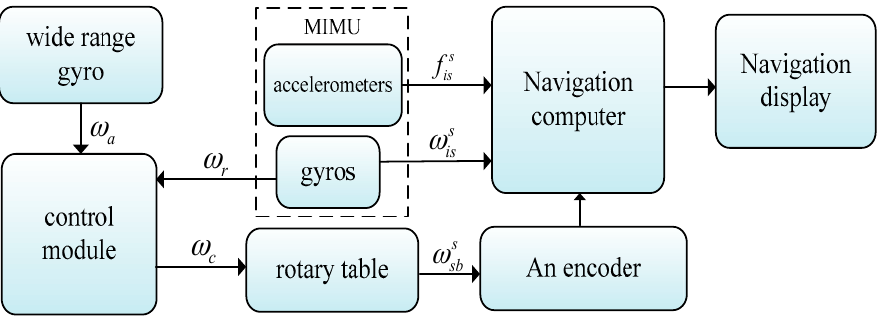
Figure 2. Block diagram of the principle behind the RSSINS.